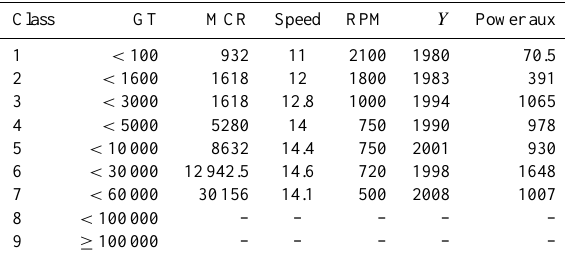
Table A7. Class medians for other vessels where no type specifica- tion could be